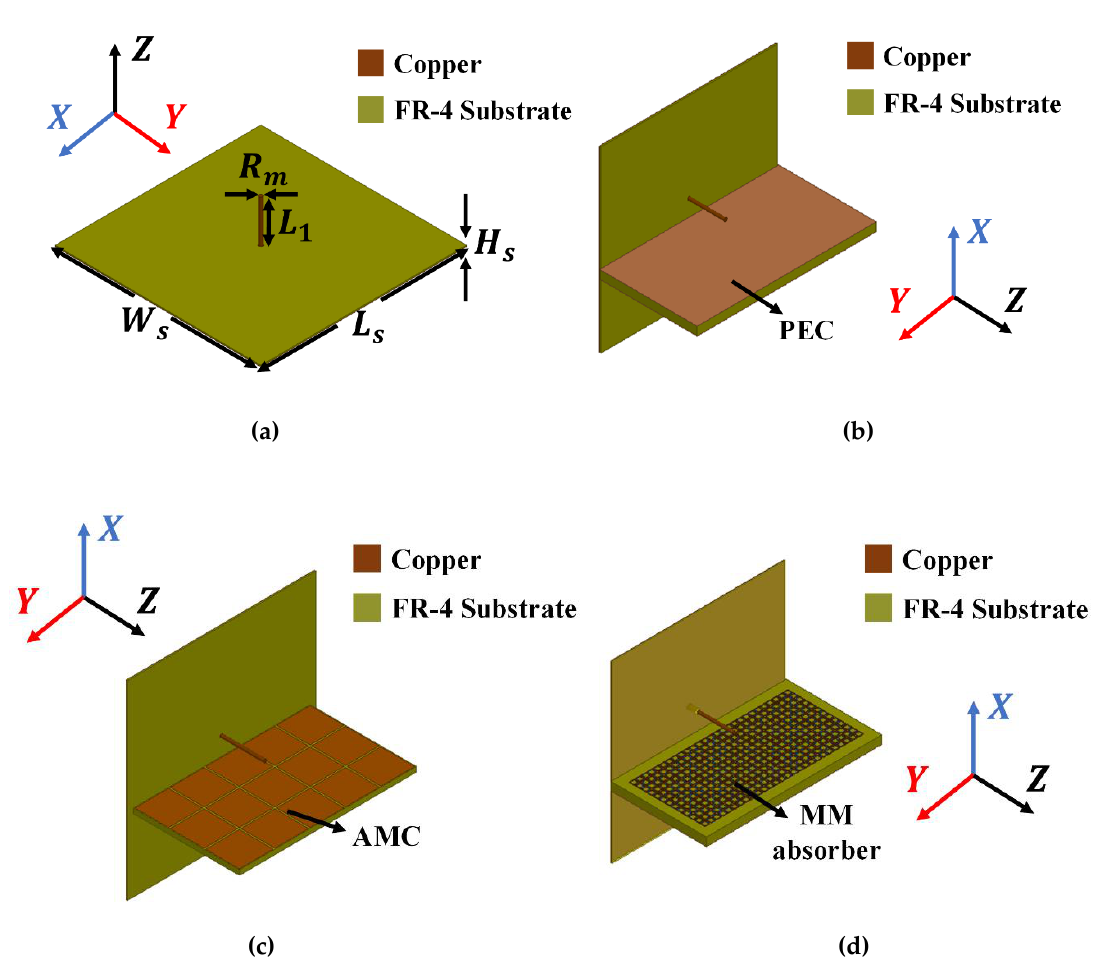
Figure 1. Monopole antennas: ( a ) reference antenna 1: bare, ( b ) reference antenna 2: perfect electric conductor (PEC), ( c ) reference antenna 3: artificial magnetic conductor (AMC), and ( d ) proposed antenna: metamaterial (MM) absorber.